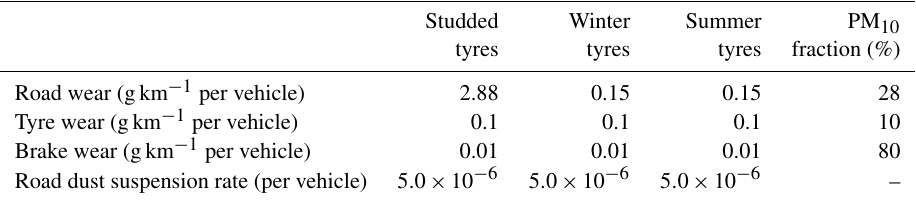
Table 3. Wear and suspension rates for light-duty vehicles and the fraction of wear material in the size range of PM 10 used in the NORTRIP